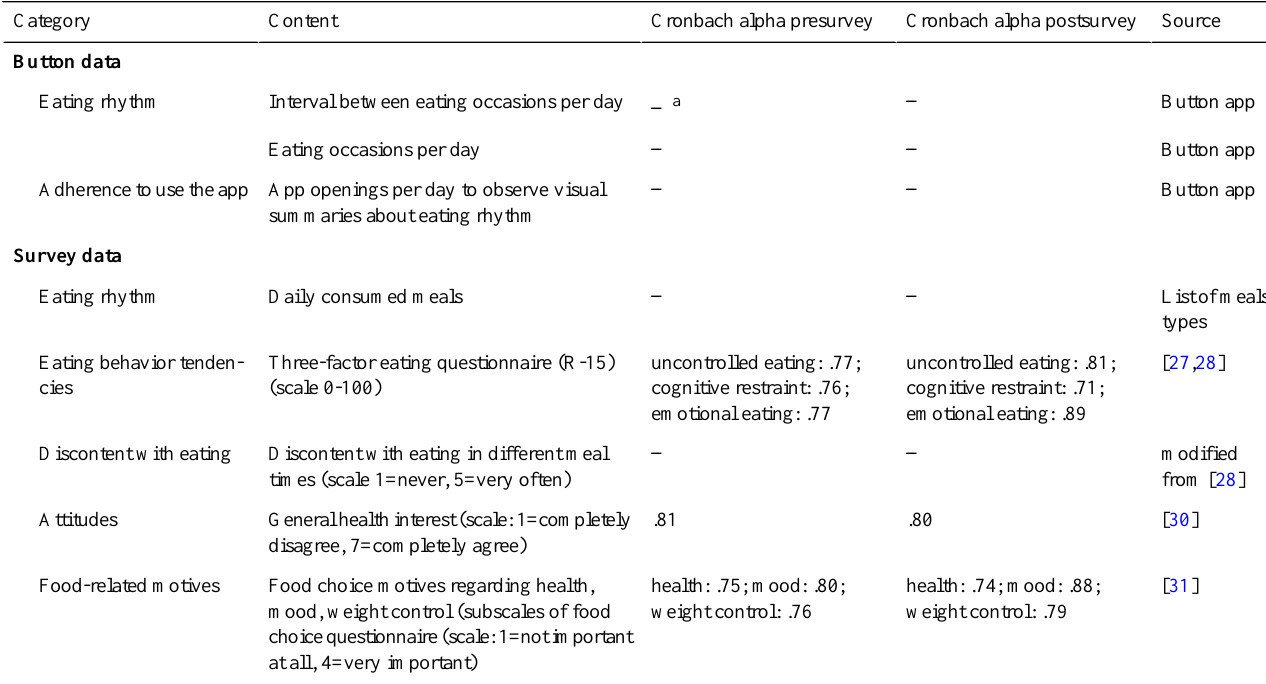
Table 2. Reliability and sources of independent variables (Cronbach alpha values higher than .70 are considered